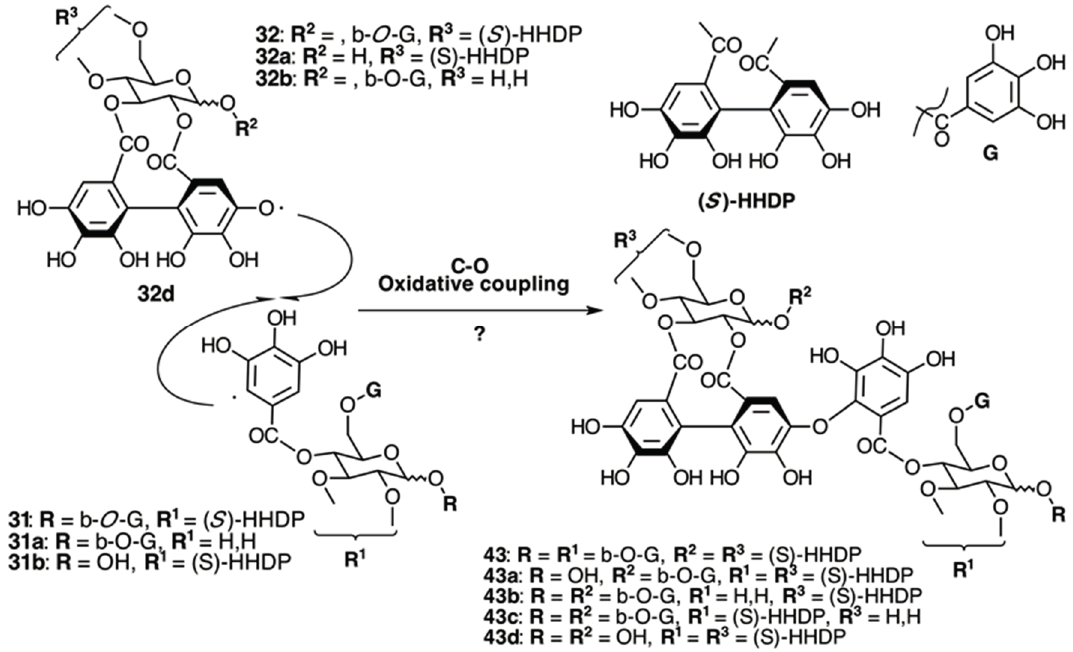
Figure 11. Route B in the biogenesis of dimeric ellagitannins in Melastomataceae. ? = Enzymes and reaction conditions are not yet clarified.